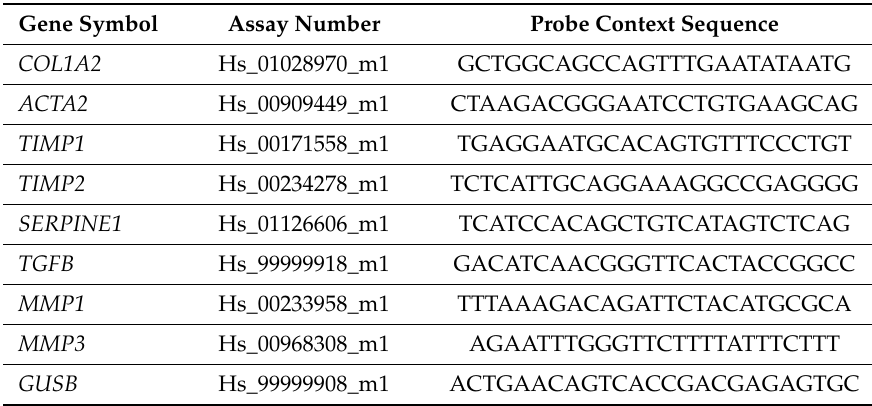
Table 1. Gene expression